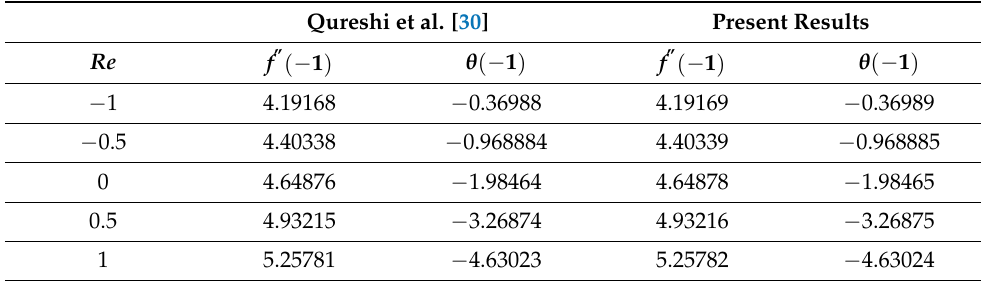
Table 8. Comparison results in momentum and heat transfer at the lower plate for α = − 1, ϕ 1 = 0.06, ϕ 2 = 0.06, M =